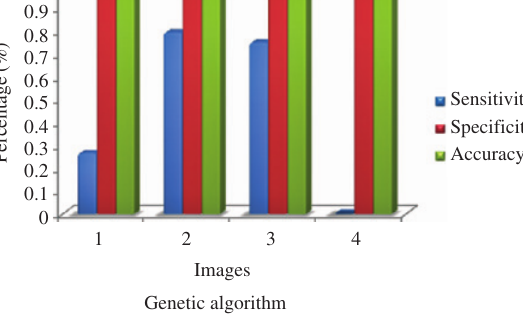
Figure 5: Performance Graph for Three Optimization